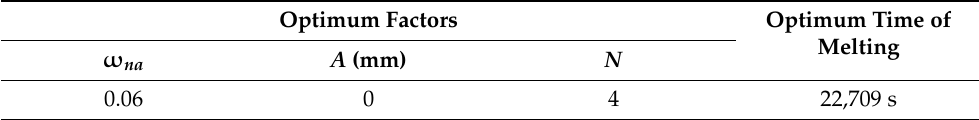
Table 5. The optimum values of the controlling parameters.